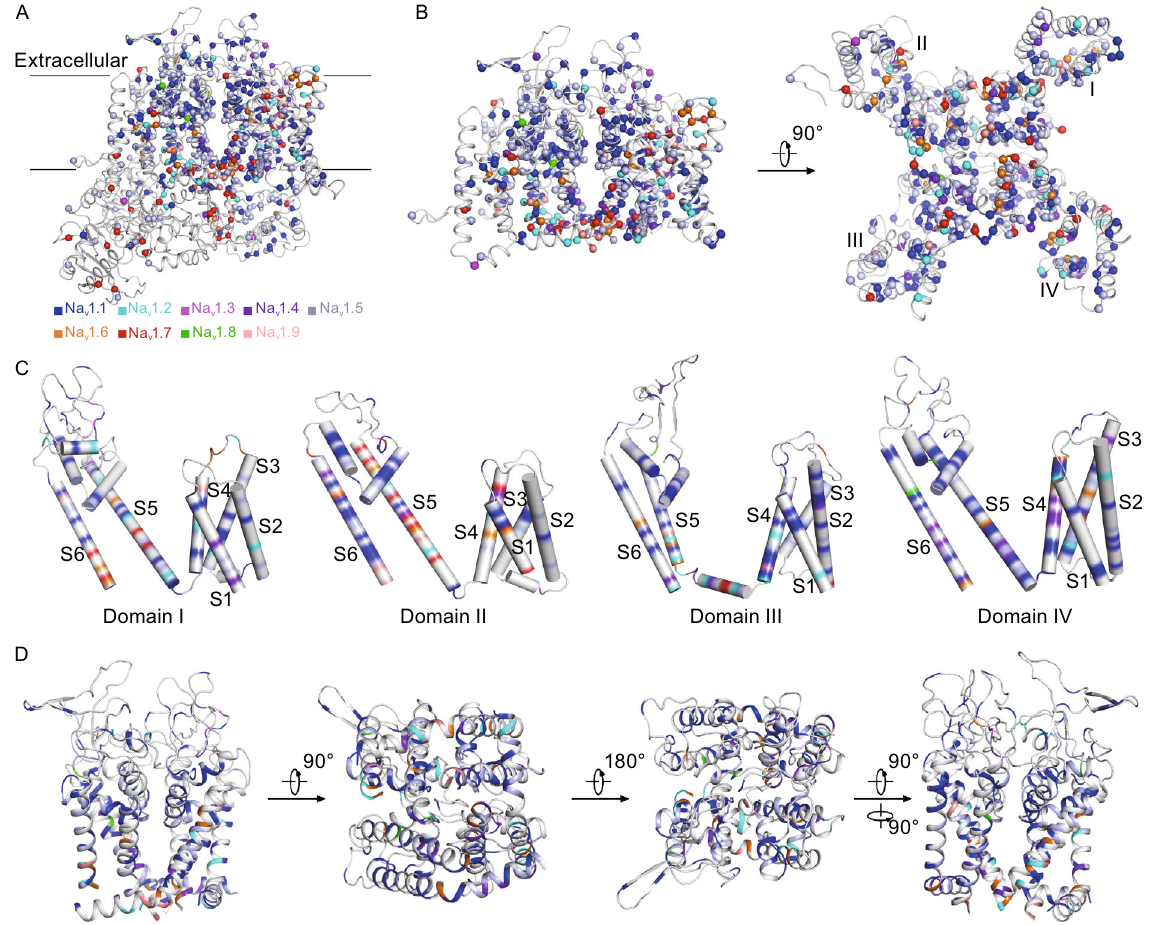
Figure 4. Mutations that cause sodium channelopathies are plotted on the Na v 1.7 sodium channel model. (A) The amino acid residues related with sodium channelopathies are mapped on the Na v 1.7 structure model. All mutated residues are shown in spheres and colored for Na v 1.1 (blue), Na v 1.2 (cyan), Na v 1.3 (magenta), Na v 1.4 (purple blue), Na v 1.5 (pale cyan), Na v 1.6 (orange), Na v 1.7 (red), Na v 1.8 (green), and Na v 1.9 (salmon). (B) The distribution of sodium channelopathy-related mutations on the transmembrane regions of the Na v 1.7 structure model. Mutations of the VSDs and the pore domain are shown from the intra-membrane and intracellular views. (C) The mutation distributions for the four domains. S1 – S6 segments are shown in cylindrical helices. (D) Mapping mutations to the pore domain in four different